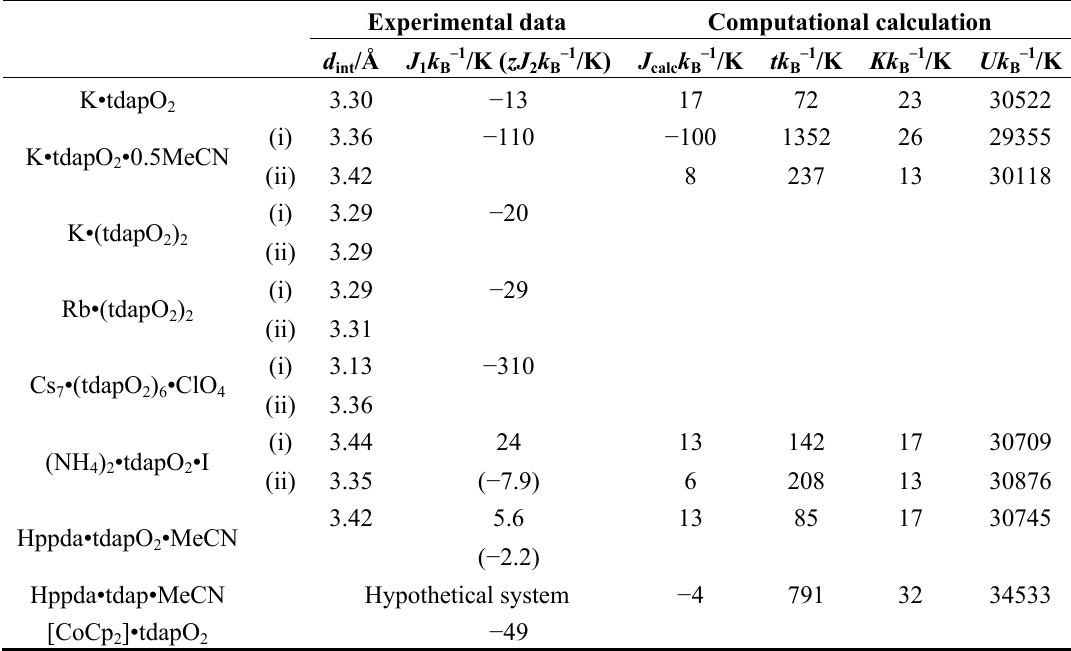
Figure 26. Active MOs resulting from a CAS[2,2]SCF calculation performed for the triplet state of a dimer extracted from the crystal structure of K•tdapO from [48]. Copyright 2013 American Chemical